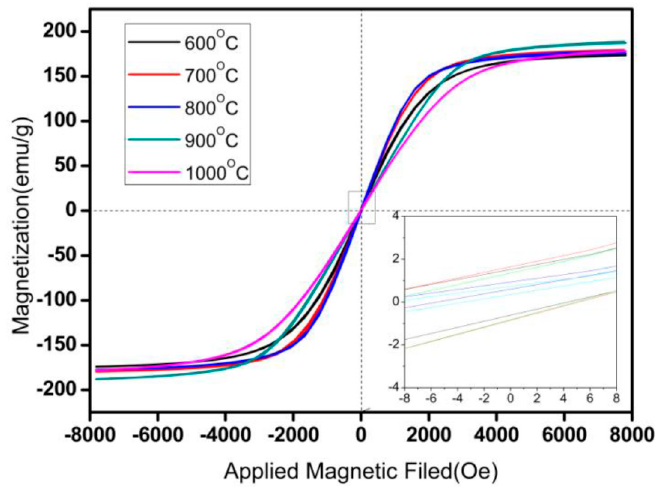
Figure 11. The hysteresis loops of Fe-Si/MnZn(Fe 2 O 4 ) 2 composites for different sintering temperatures. The inset in figure is the magnified image of the selected region. Table 2. Main magnetic parameters of our specimens and other study.